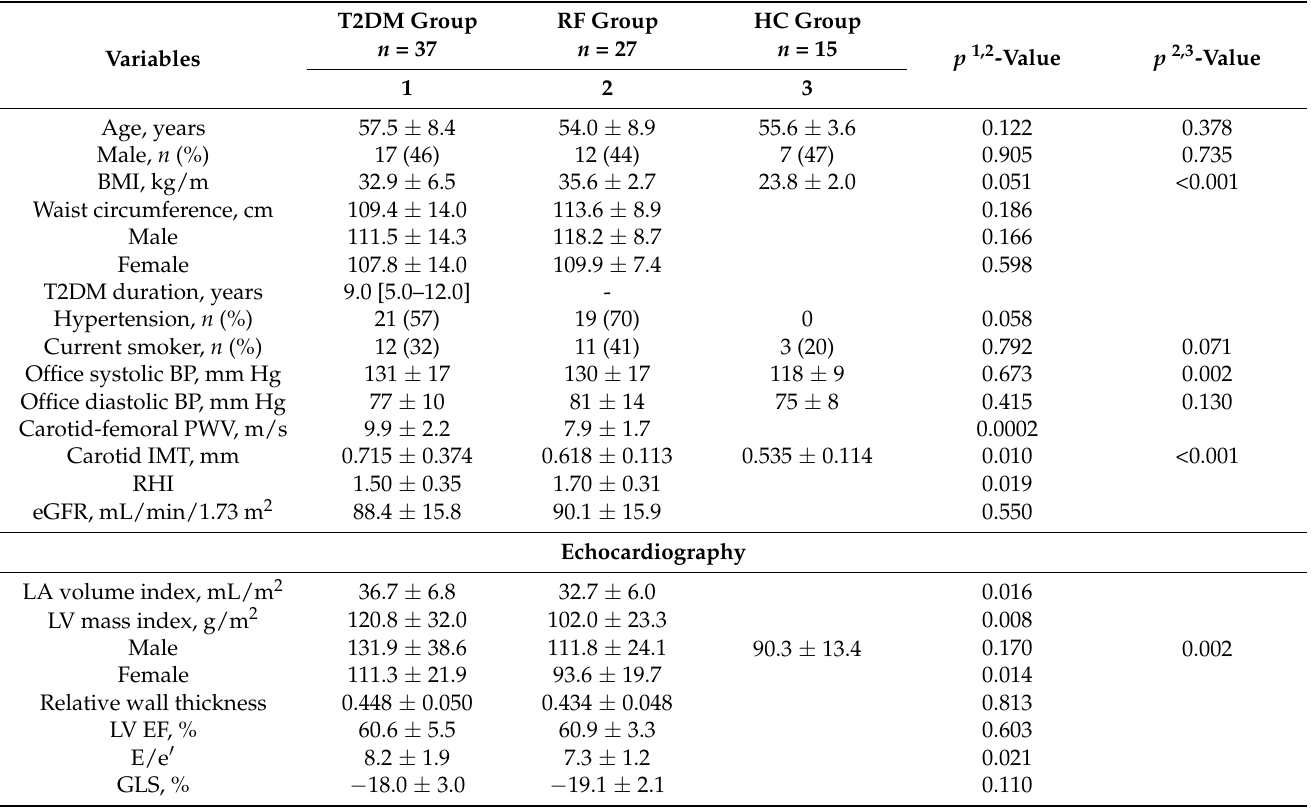
Table 1. Baseline characteristics of study